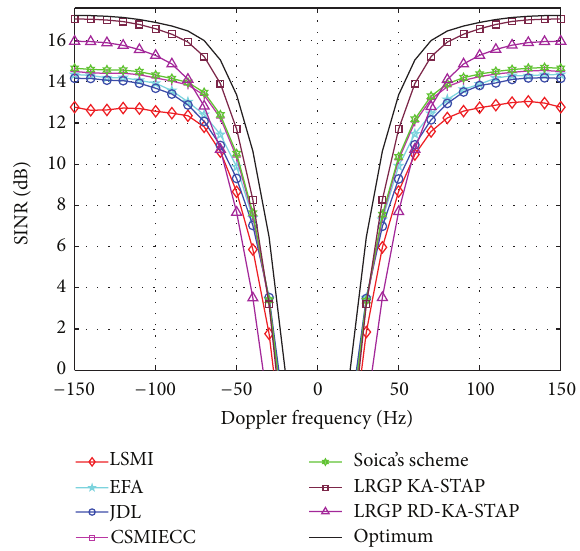
Figure 7: SINR performance versus the target Doppler frequency. The number of snapshots used for training in the LSMI, EFA, JDL, and CSMIECC algorithms is set to 48, while we only use 4 snapshots for our proposed algorithms.